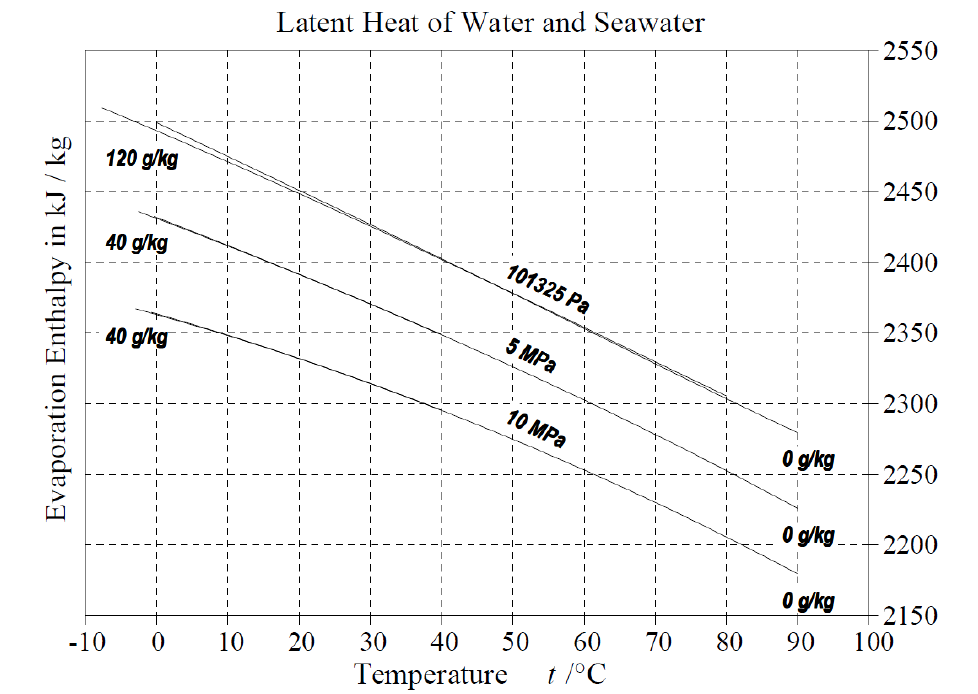
Figure 10. Latent heat of evaporation of seawater, calculated from Equation 20 with the source-code library of TEOS-10 for salinities between 0 and 120 g kg −1 at a surface pressure of 1013.25 hPa, and up to 40 g kg −1 for higher pressures between 5 and 10